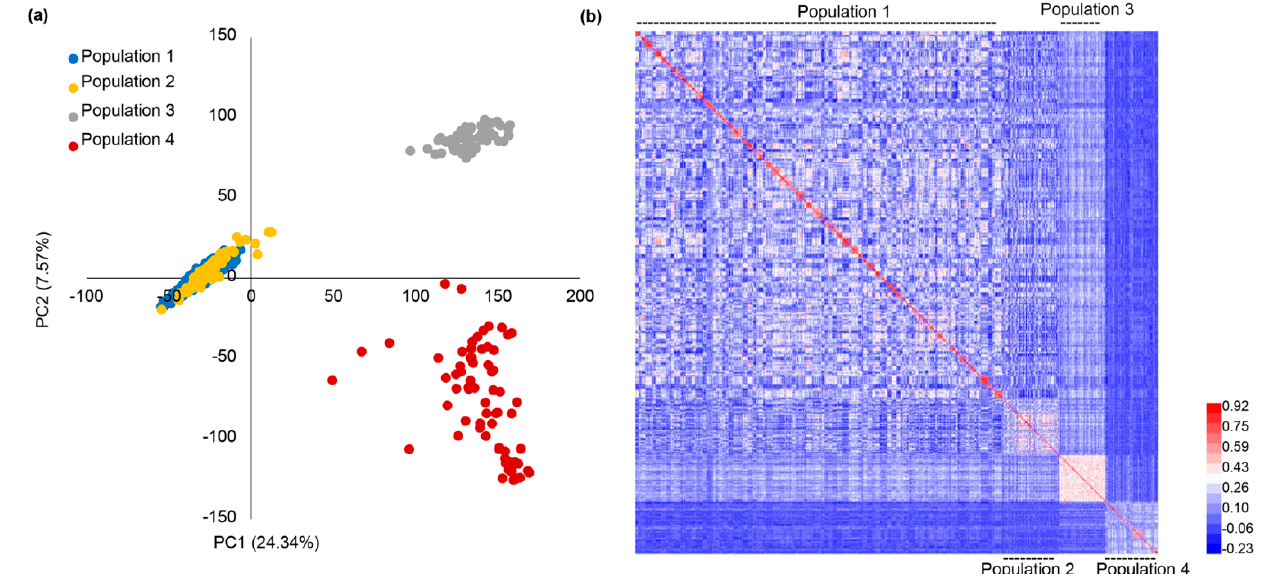
Figure 1. PC analysis and genetic similarity among the four populations. ( a ) PC analysis of the four populations on the basis of 18,702 SNP markers; ( b ) the genetic similarity heatmap was used to demonstrate the genetic relatedness among the four populations.